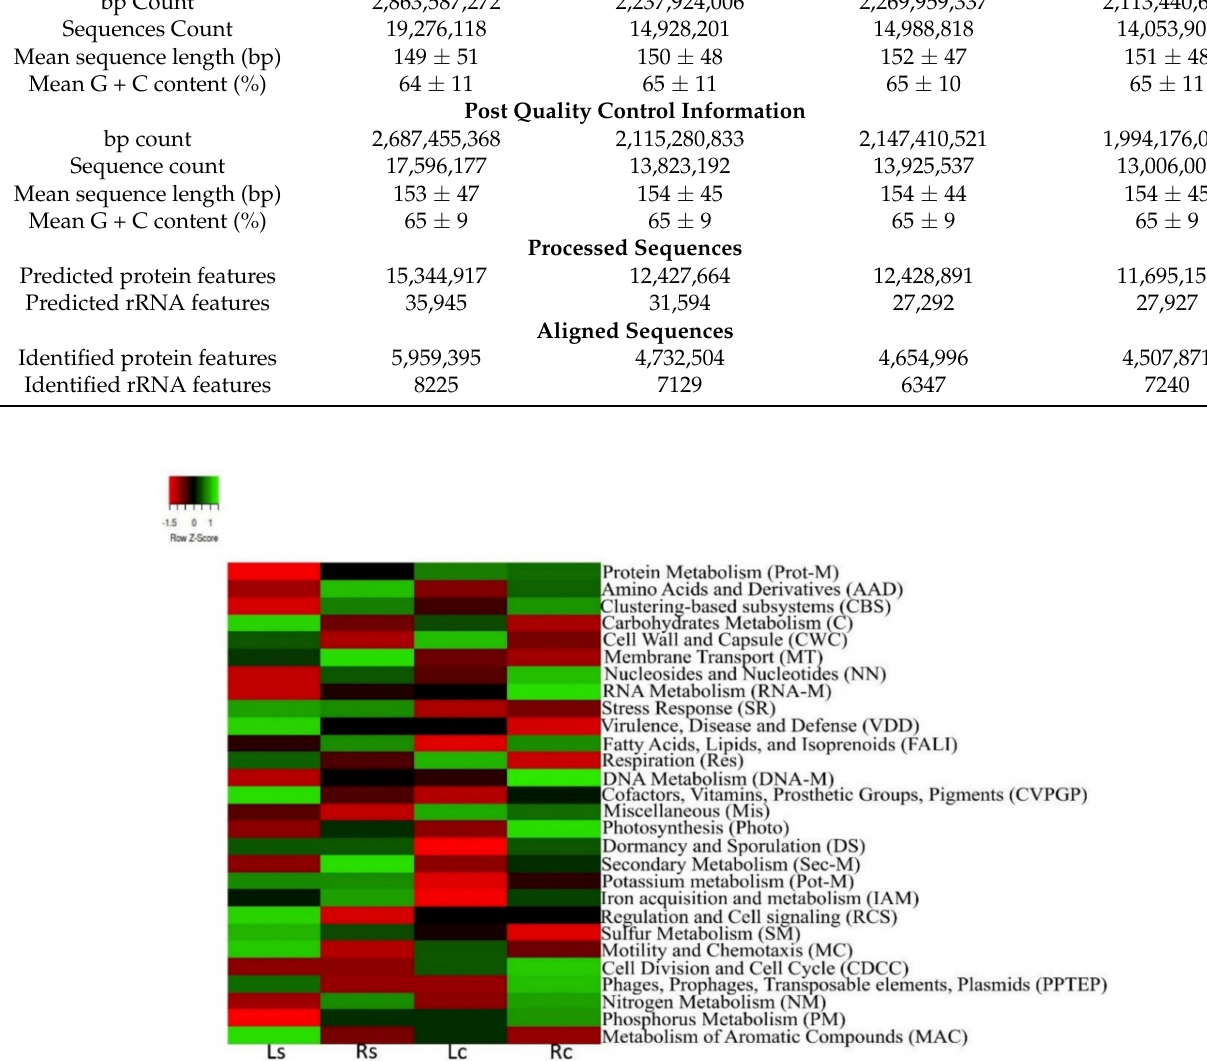
Figure 1. The major metabolic hits in maize rhizosphere soils and their bulk samples. The z-score (scale bar) represents the color saturation gradient based on the relative abundance of functional hits in subsystem level 1 (MG-RAST) of three replicates deduced from the maize rhizosphere (Ls and Rs) and bulk (Lc and Rc) soils. All statistical analyses, including mean values and analysis of variance (ANOVA) were done using GraphPad Prism (v5.0) as shown in Table